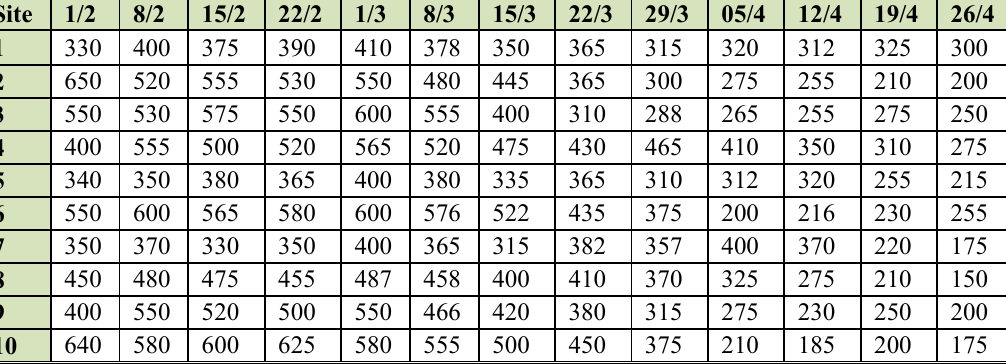
Table 6: Total Hardness values